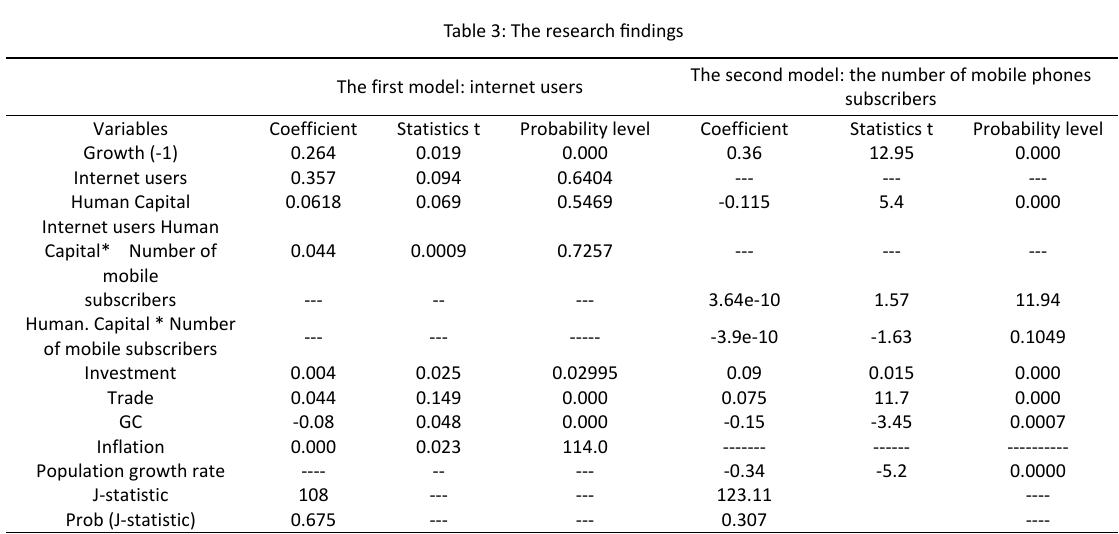
Table 3: The research findings